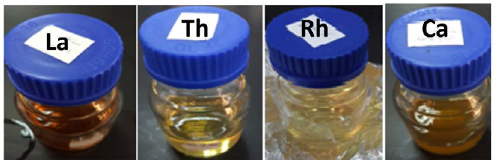
Fig. 1. (La) Lawsonia inermis , (Th) Thymus vulgaris , (Rh) Rhamnus frangula and (Ca) Camellia sinensis before added the leaf extracts with aqueous solution of silver nitrate